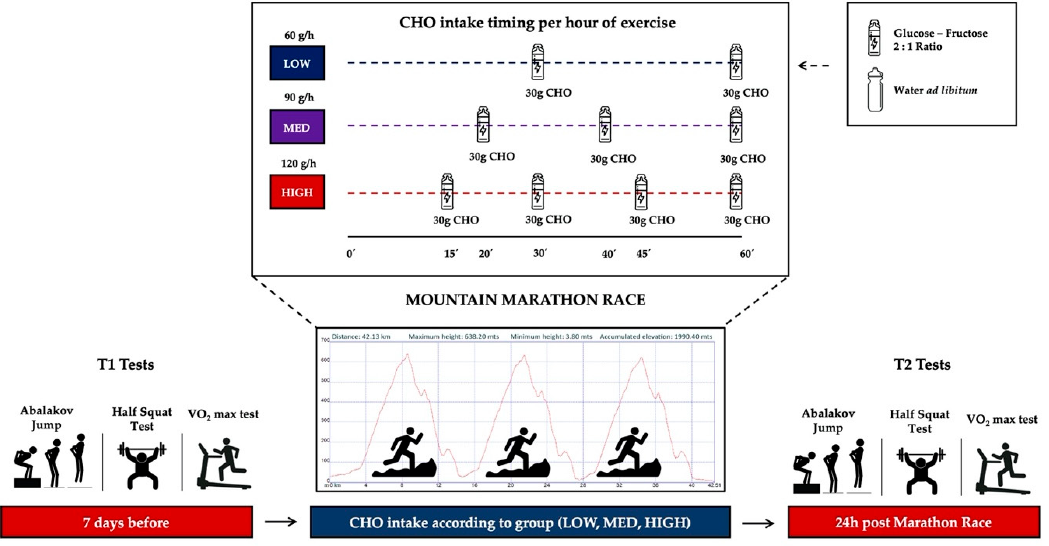
Figure 1. Experimental design of study including pre- and post- tests and race fueling protocol and timing. CHO: Carbohydrate.